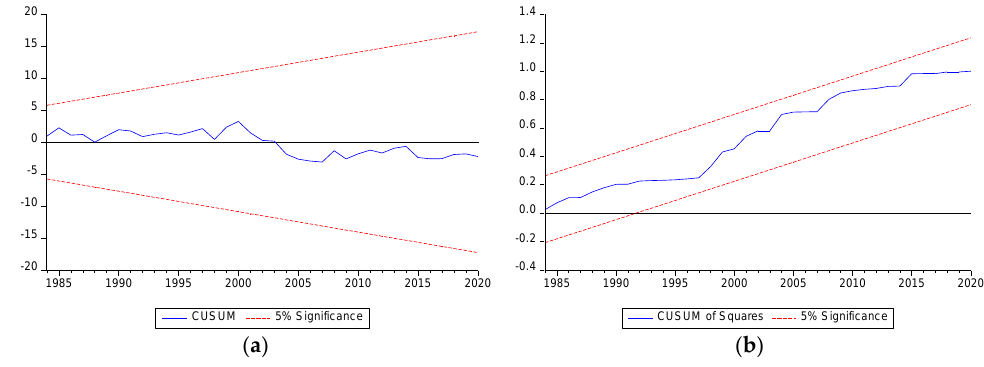
Figure 9. ( a ) CUSUM Test for Model 3. ( b ) CUSUMQ Test for Model 3.